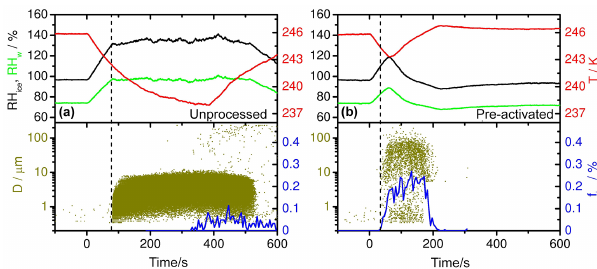
Figure D1. Ice nucleation characteristics of unprocessed (a) and pre-activated (b) GSG soot particles during expansion cooling. The data types are the same as shown in Fig.